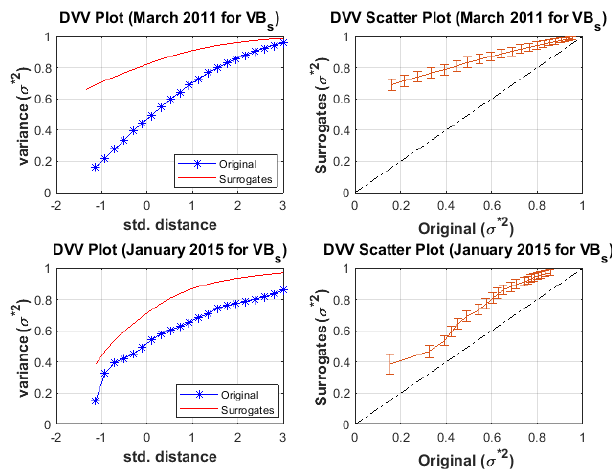
Figure 11. The DVV plot and scatter plot for VB s during moderate geomagnetic storm for March 2011 and January 2015.